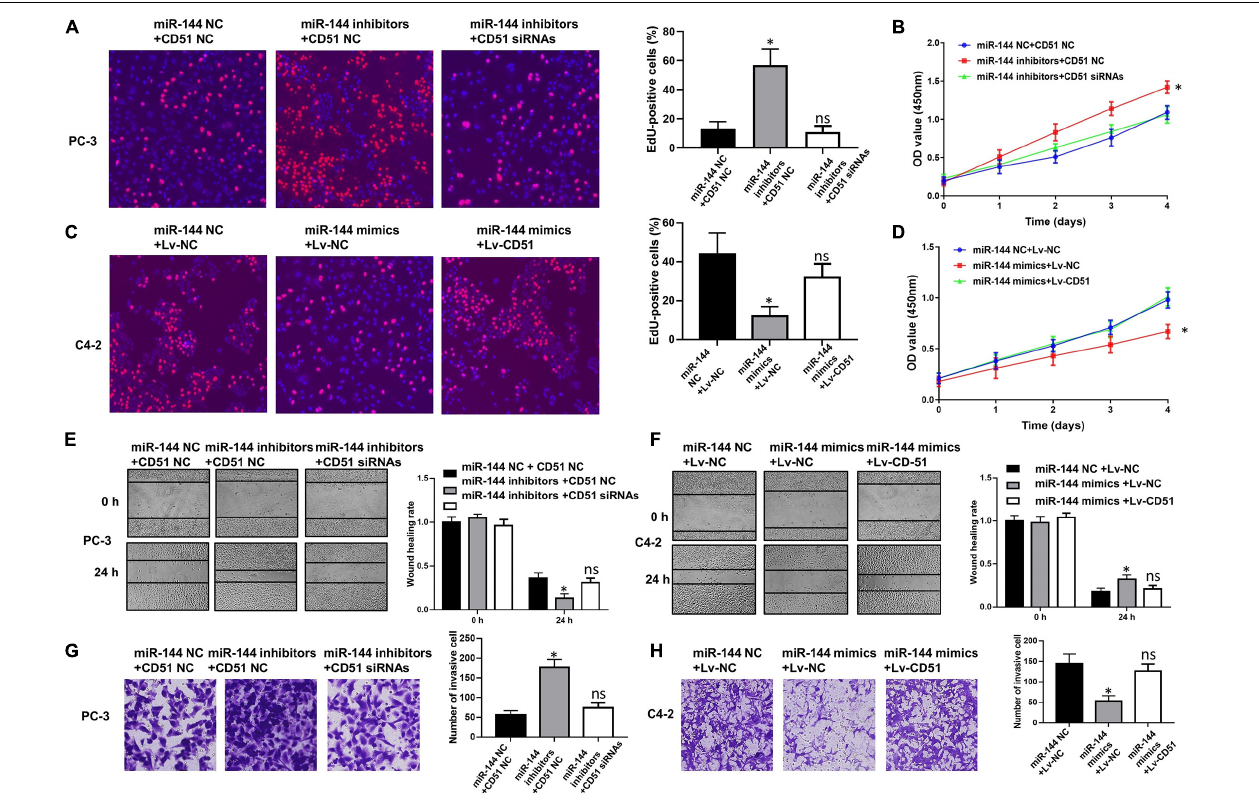
FIGURE 9 | CD51 is the functional mediator of miR-144-induced proliferation and invasion of CRPC cells. (A,C) The effects of CD51 on miR-144 mediated proliferation of PC-3 (A) and C4-2 (C) cells, as detected by EdU assay; (B,D) The effects of CD51 on miR-144 mediated cell proliferation of PC-3 (B) and C4-2 (D) cells, as detected by CCK-8 assay; (E) The effects of CD51 siRNA on miR-144 inhibitors mediated migration of PC-3 cells; (F) The effects of Lv-CD51 on miR-144 mimics mediated migration of C4-2 cells; (G,H) The effects of CD51 on miR-144 mediated invasion of PC-3 (G) and C4-2 (H) cells, as detected by EdU assay; Data are expressed as the mean ± SE . * P < 0.05, ns, not significant. The representative results of three independent experiments are